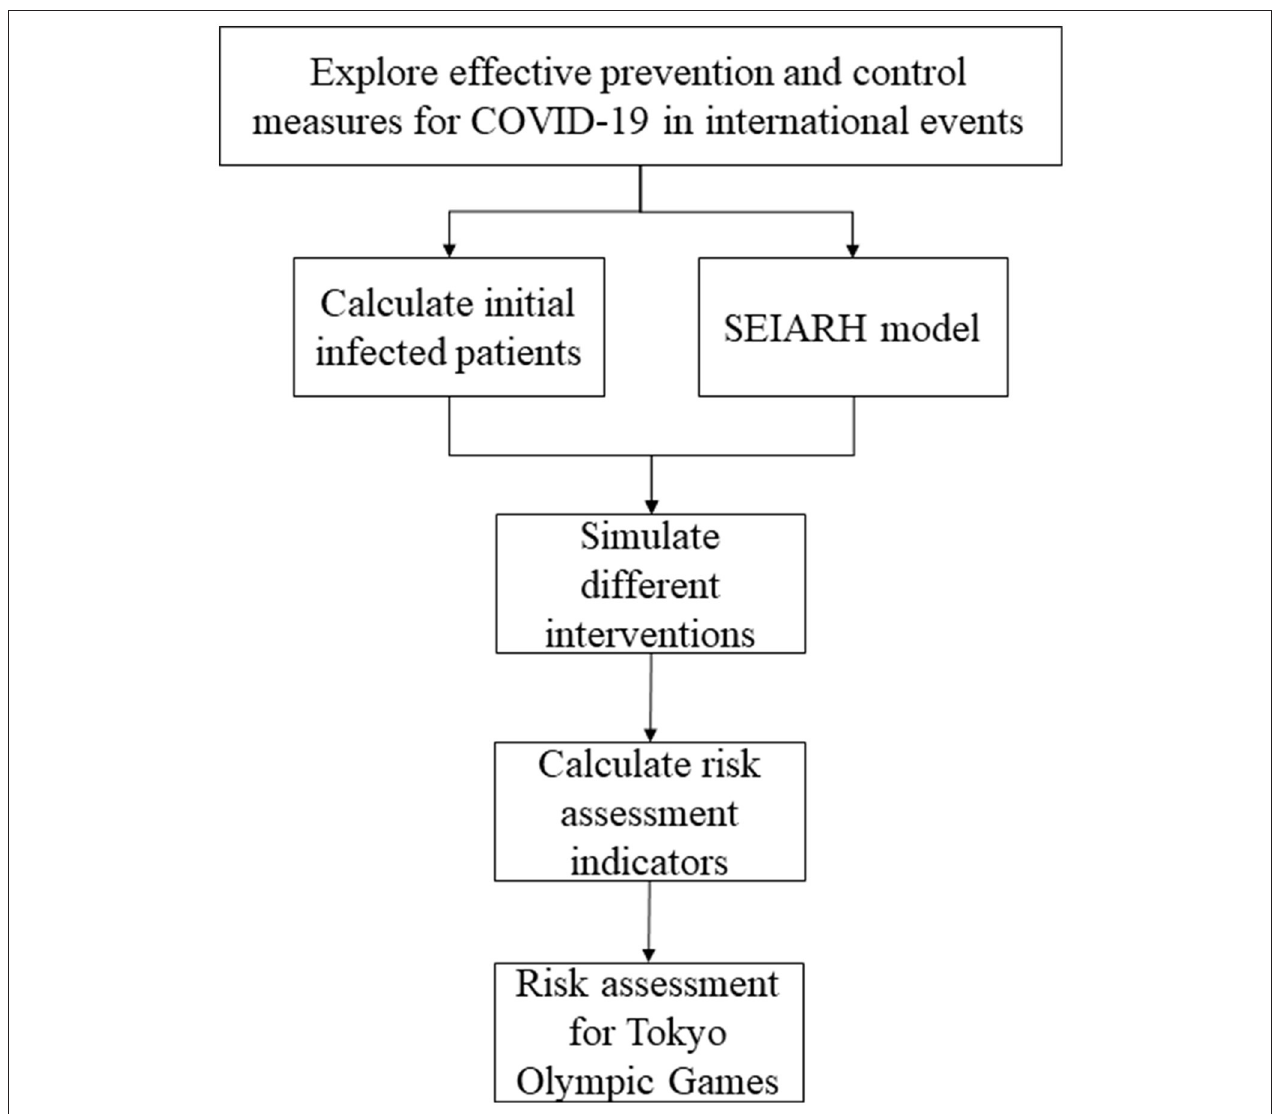
FIGURE 1 | The procedure of